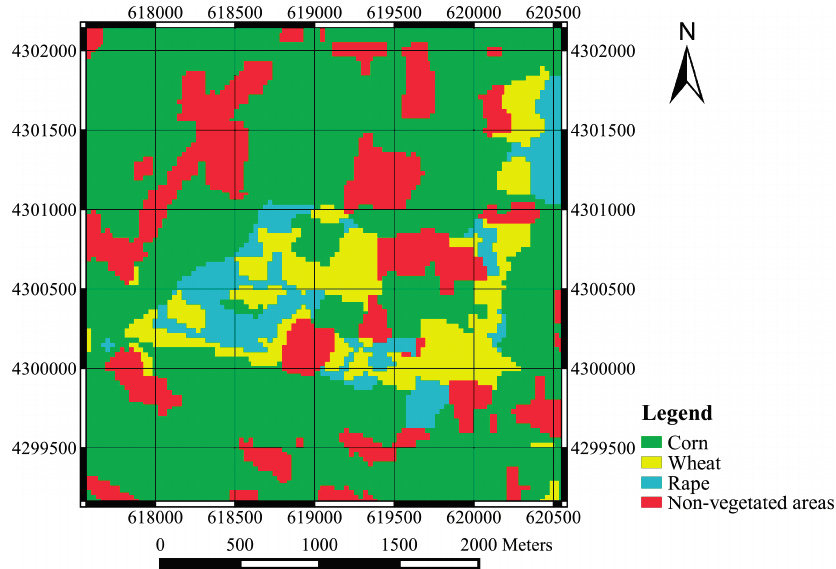
Figure 2. The land-cover map of the 3 km × 3 km study area in the Heihe River basin, China. The major cover types were corn ( green ), wheat ( yellow ), rape ( cyan ) and non-vegetated areas ( red ). The projection is UTM 47 North,